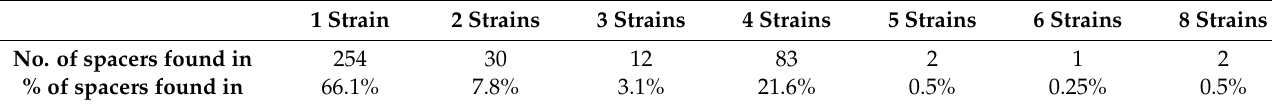
Table 2. Frequency of occurrence of spacers in P. larvae